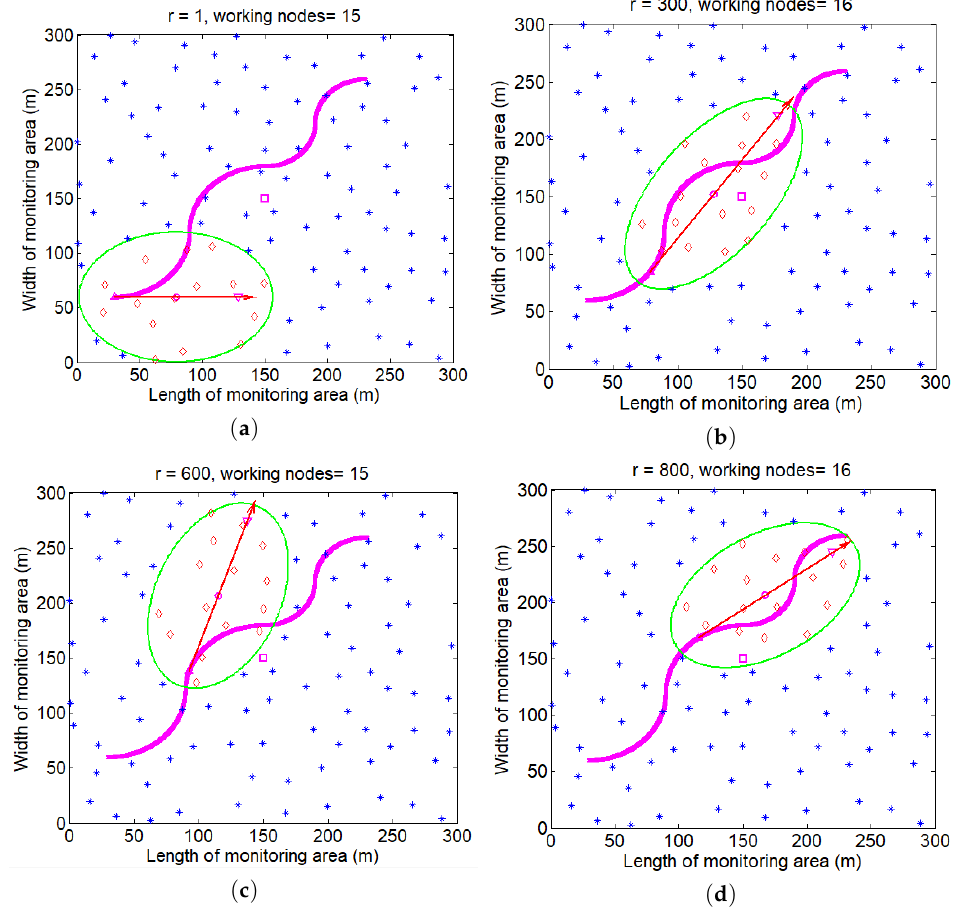
Figure 5. Change of target position and working node selection.